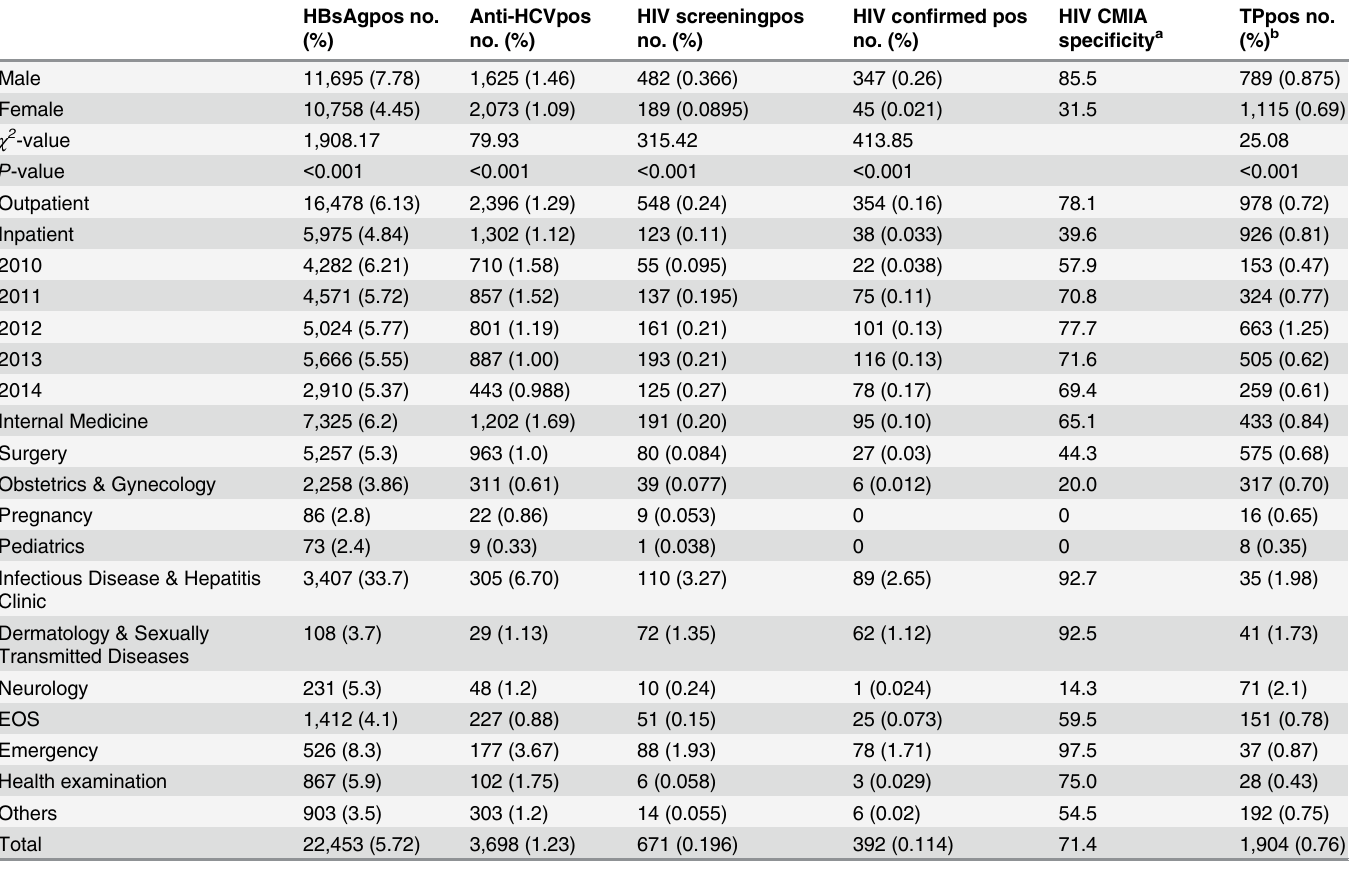
Table 2. Seroprevalences of Hepatitis B Virus, Hepatitis C Virus, Human Immunodeficiency Virus, and Treponema pallidum at Peking Union Medi- cal College Hospital (2010 – 2014). HBsAgpos no.